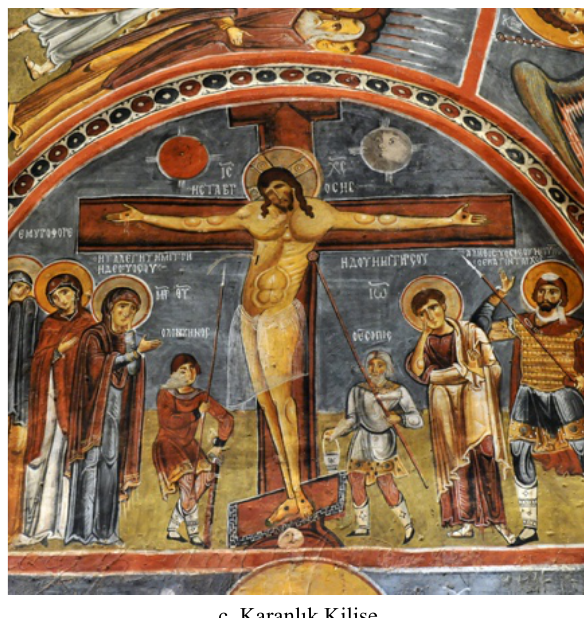
Figure 11. The Comparison of the current images of Crucifixion of ‘Column Churches’